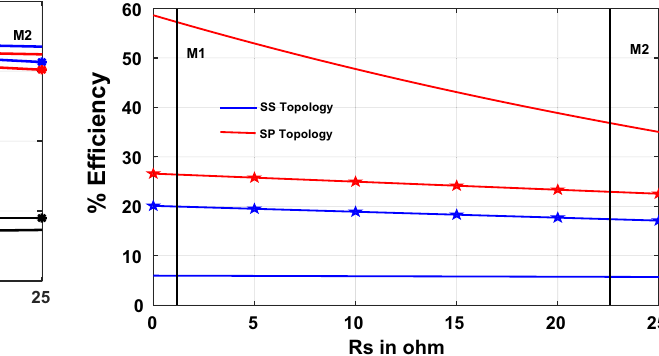
Figure 4: Primary compensation capacitance with the e ff ect of sec - ondary coil resistance R 2 . R L = 50 Ω ( no mark ) and R L = 200 Ω ( with point marked ) .